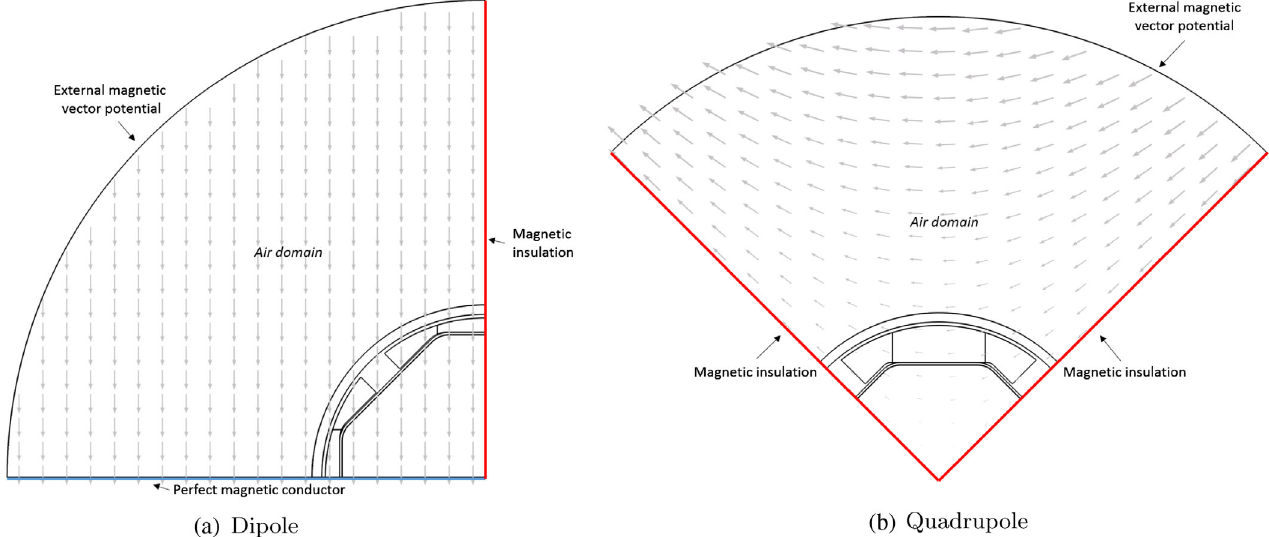
FIG. 5. Symmetry conditions (in blue and in red) applied on the straight edges to reduce the modelling domain in case of a dipolar (a) and quadrupolar (b) magnetic field. The field lines are shown in gray. For both cases the external vector potential is applied on the round edge.